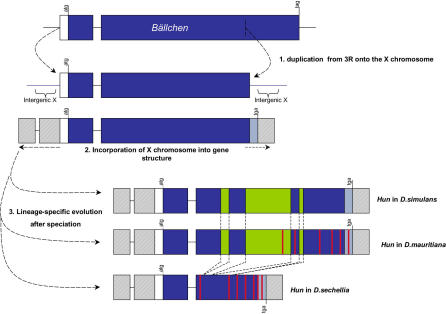
A Model for the Origin and Evolution of Hun
Striped boxes indicate newly acquired UTR regions, white boxes indicate the Bällchen 5′ region included in duplication, grey boxes indicate newly acquired protein-coding regions, green boxes indicate regions deleted from the D. sechellia copy, and red bars represent premature stop codons.